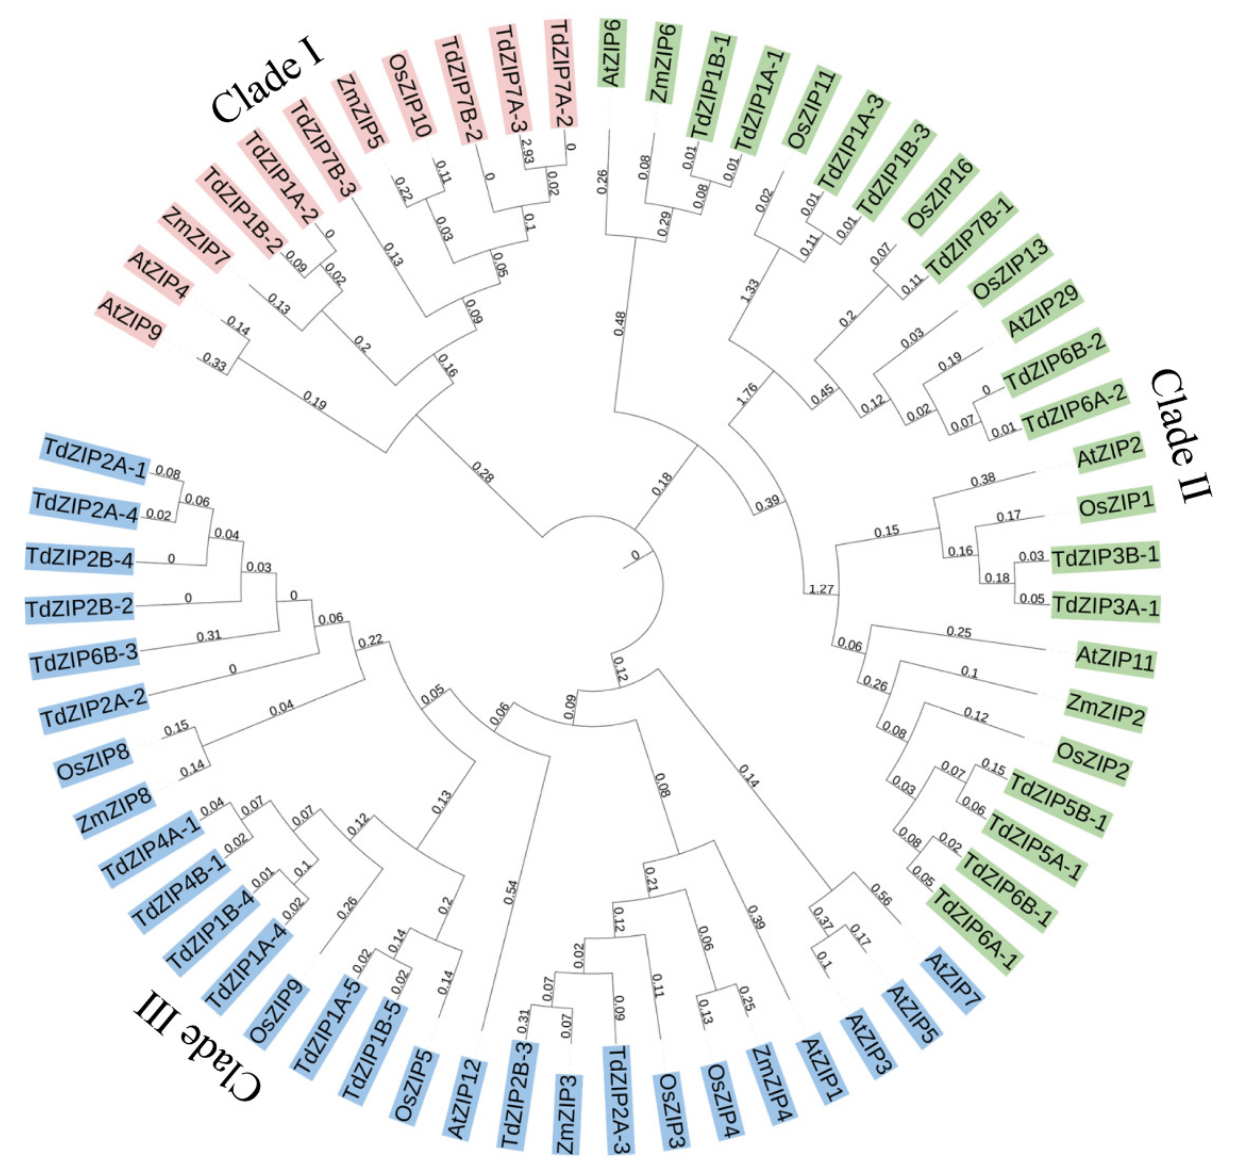
Figure 1. Phylogenetic relationships of the 33 TdZIPs , 11 OsZIPs , 7 ZmZIPs , and 11 AtZIPs . The subgroups (clades I, II, and III) of the ZIPs were marked in different color.